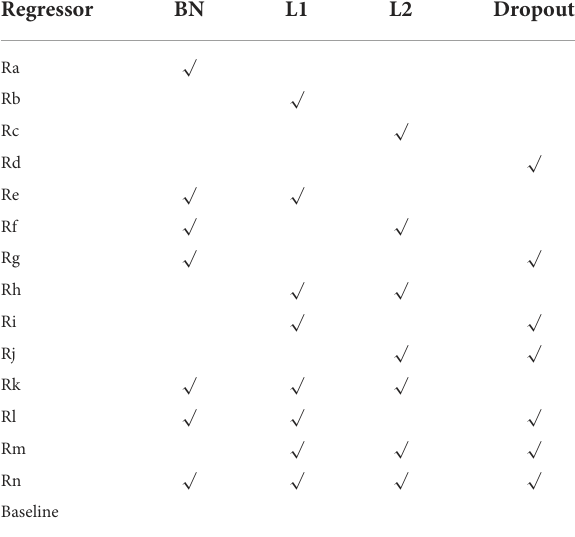
TABLE 1 Regressor design